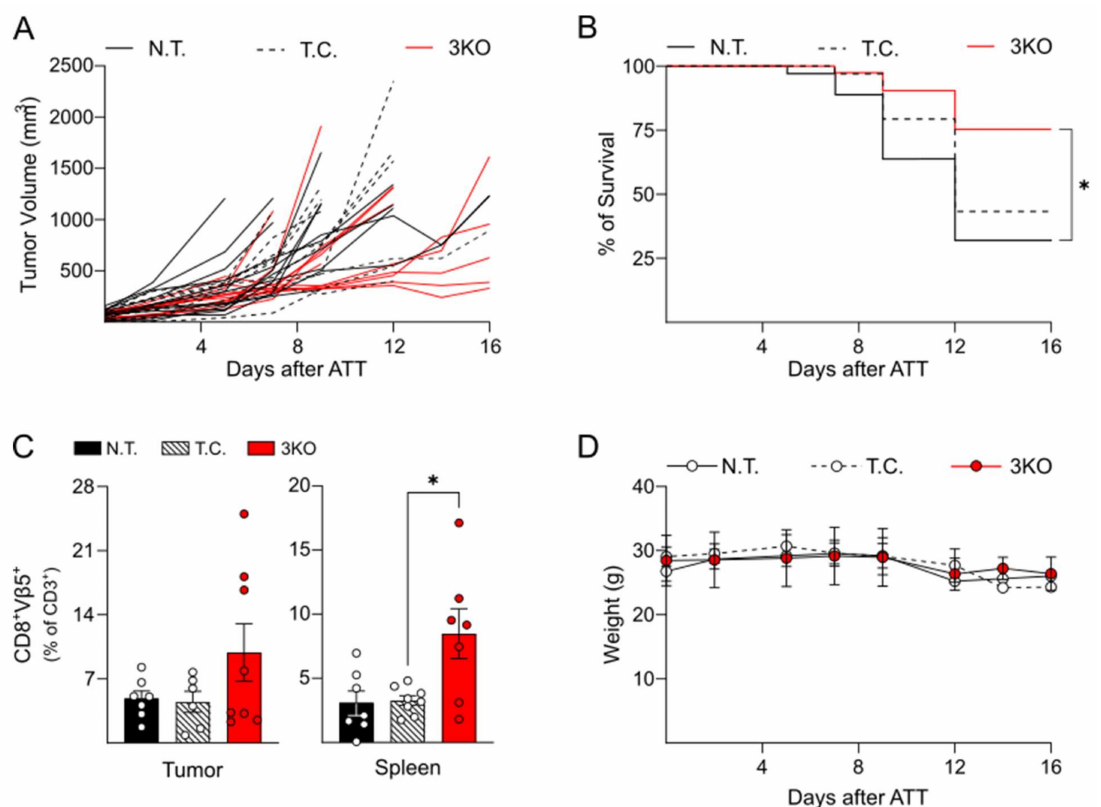
Figure 3. Effect of 3KO OT-1 CD8 + adoptive T cell transfer (ATT) on B16 tumor growth and survival. ( A ) Tumor growth after ATT of not transfected, transfection control, and triple CRISPR/Cas9 edited T cells. After ATT B16 tumors were measured every 2–3 days over a period of 16 days and mice were sacrificed after 16 days or when a tumor volume of 1500 mm 3 was reached (experimental endpoints). ( B ) Survival rate after B16 xenograft. Percent of survival was calculated over a period of 16